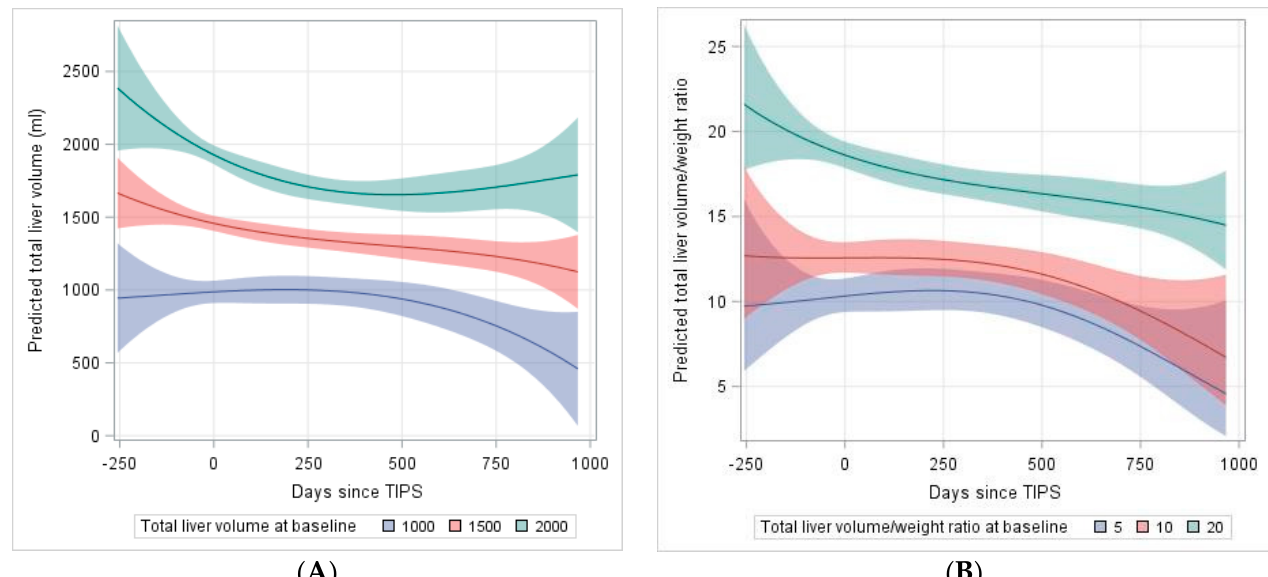
Figure 2. Explorative model of ( A ) total liver volume pre-TIPS to 1000 days after TIPS dependent on baseline liver volume ( B ) total liver volume (TLV)/weight ratio pre-TIPS to 1000 days after TIPS dependent on baseline TLV/weight ratio. TIPS was applied at day 0. The underlying models are polynomial models of 3rd degree including interactions with baseline volume (volume/weight ratio). Table 6. Regression coefficients for the explorative model for TLV/weight ratio and Table 5. Regression coefficients for the explorative model for total liver volume and time.